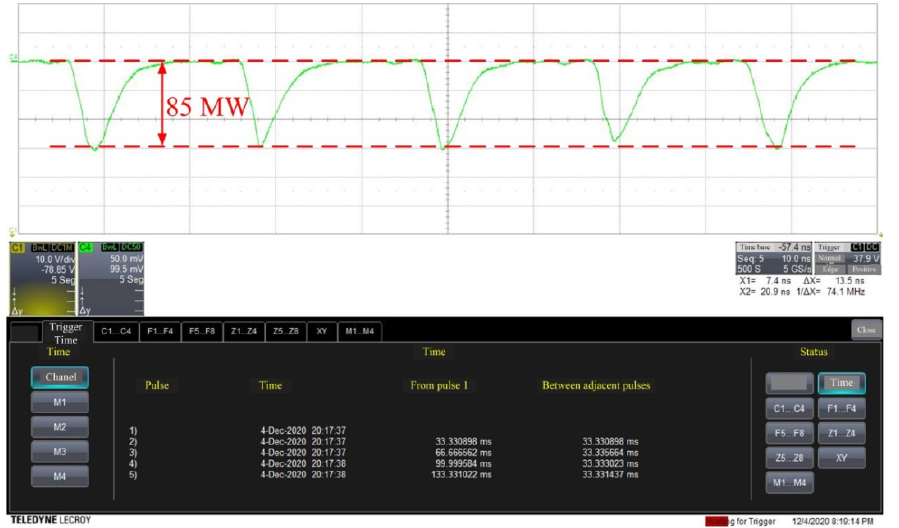
Figure 18. Screen shot of 5 microwave pulses at 30 Hz operation.